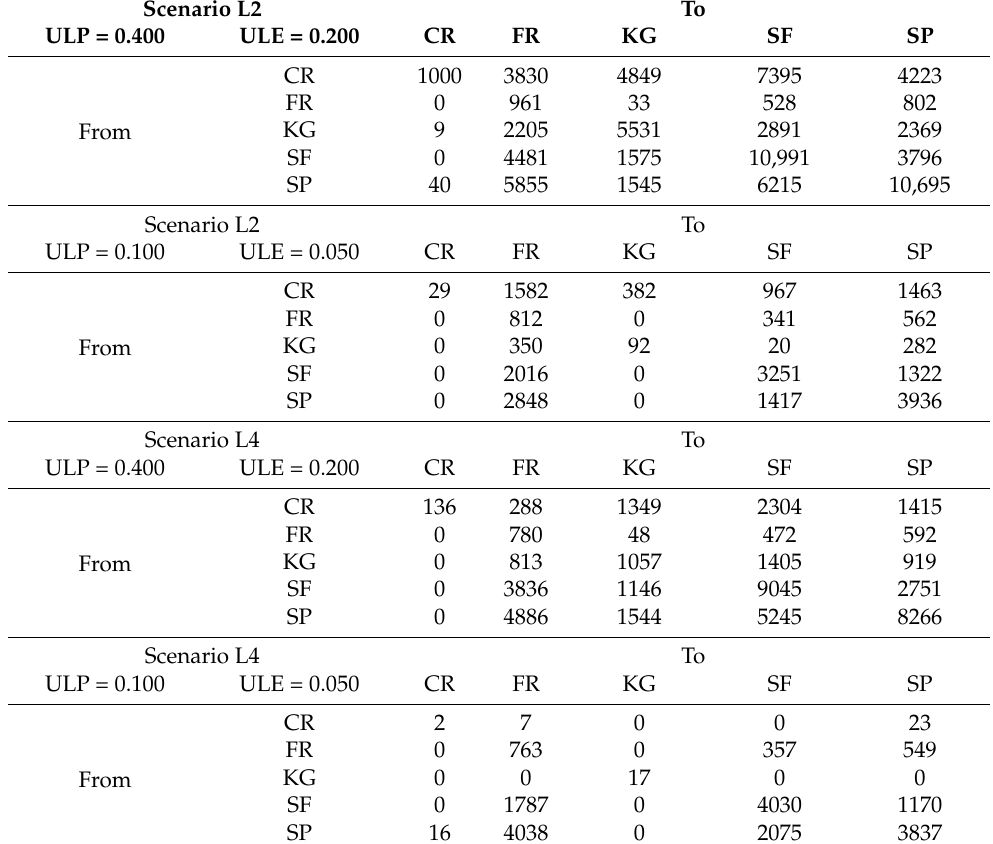
Table 11. Optimal Commuting Flows by Jurisdiction.